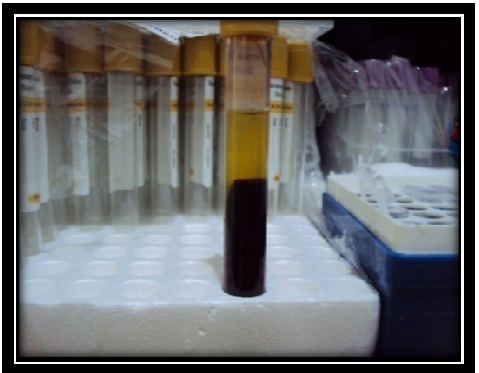
Figure 2: Blood sample after